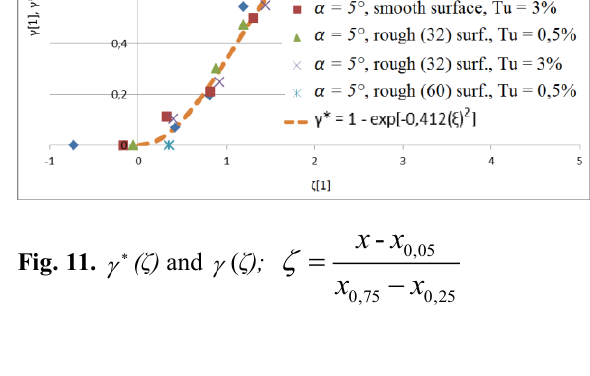
Fig. 8. (Re 2 ), H 12 (Re 2 ), γ (Re 2 ), γ(Re 2 ) IND , / U U   0 γ * (Re 2 ), α = 5° smooth surface of flat plate, Iu e = 3%